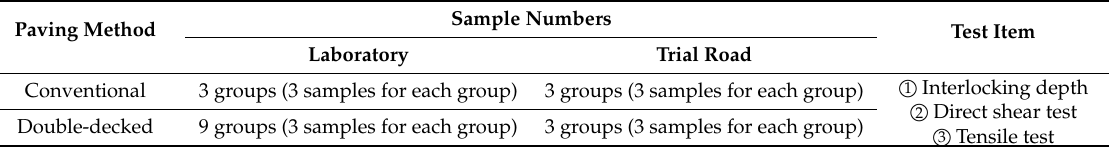
Table 3. Summary of test program.